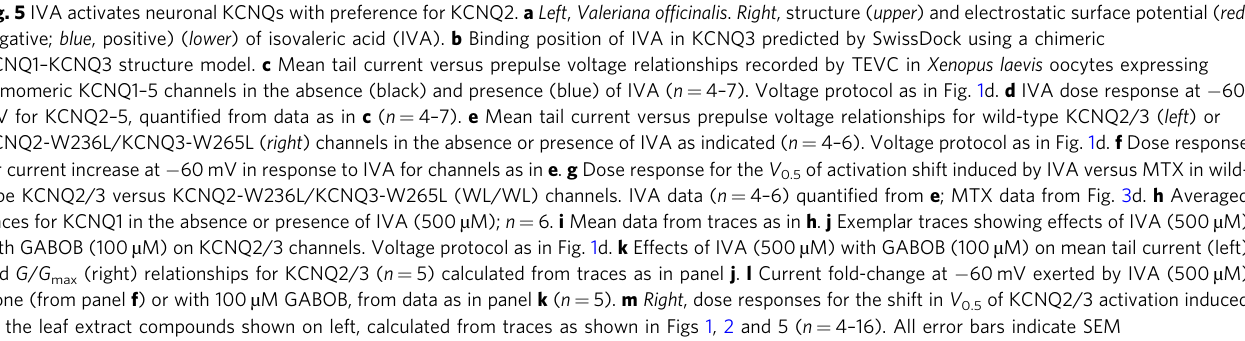
Fig. 5 IVA activates neuronal KCNQs with preference for KCNQ2. a Left , Valeriana of fi cinalis . Right , structure ( upper ) and electrostatic surface potential ( red , negative; blue , positive) ( lower ) of isovaleric acid (IVA). b Binding position of IVA in KCNQ3 predicted by SwissDock using a chimeric KCNQ1 – KCNQ3 structure model. c Mean tail current versus prepulse voltage relationships recorded by TEVC in Xenopus laevis oocytes expressing homomeric KCNQ1 – 5 channels in the absence (black) and presence (blue) of IVA ( n = 4 – 7). Voltage protocol as in Fig. 1d. d IVA dose response at − 60 mV for KCNQ2 – 5, quanti fi ed from data as in c ( n = 4 – 7). e Mean tail current versus prepulse voltage relationships for wild-type KCNQ2/3 ( left ) or KCNQ2-W236L/KCNQ3-W265L ( right ) channels in the absence or presence of IVA as indicated ( n = 4 – 6). Voltage protocol as in Fig. 1d. f Dose